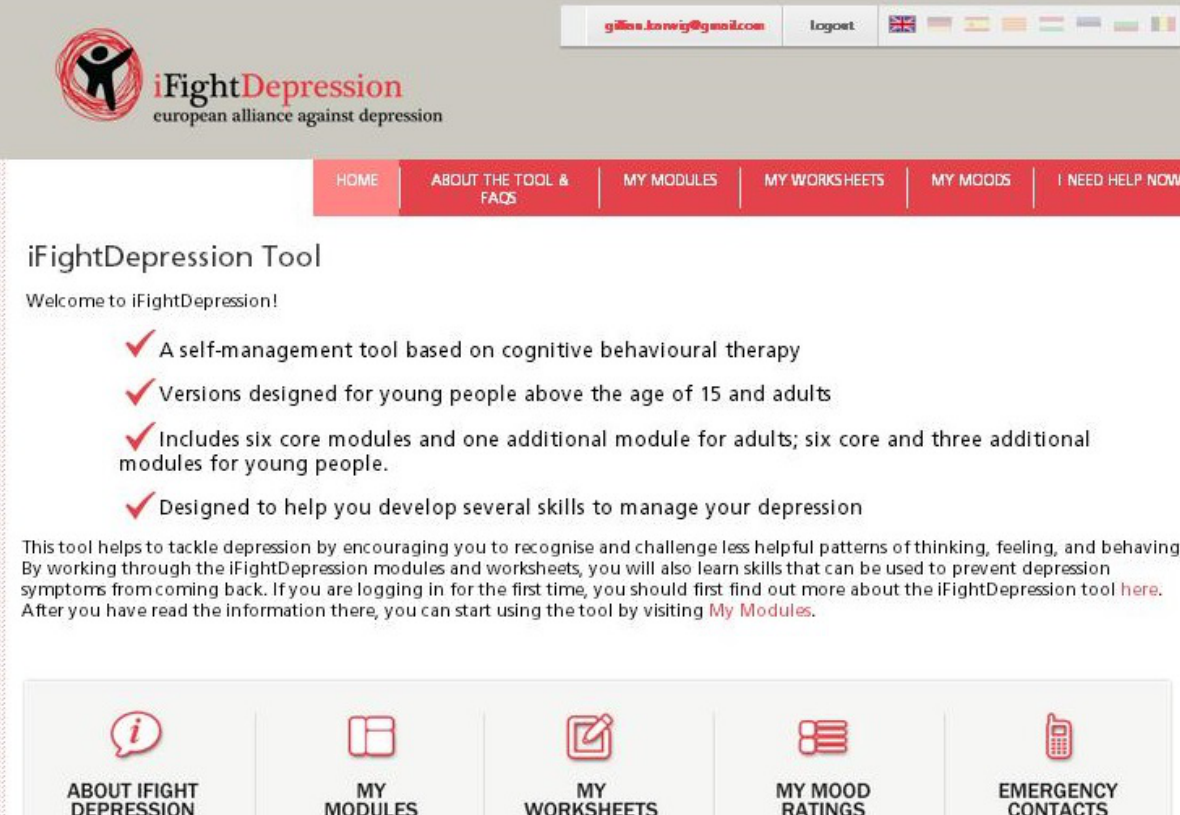
Figure 1. Home page of the iFightDepression